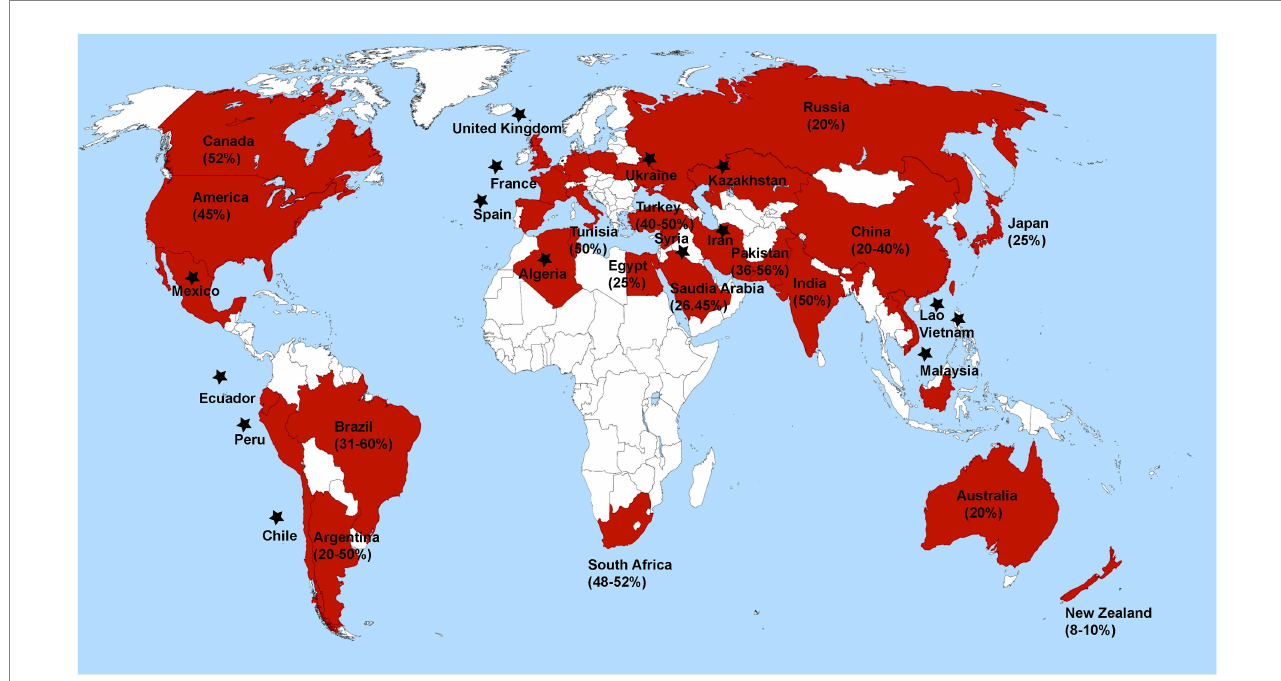
FIGURE 1 Global distribution and percent disease severity of R. solani associated with leguminous crops. Star has been placed over countries where R. solani is present, but disease severity has not been